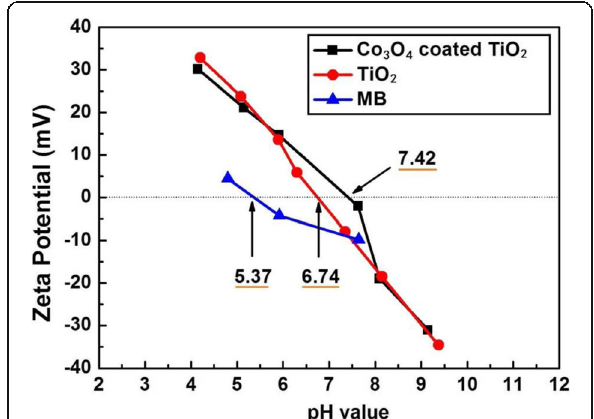
Fig. 8 Zeta potential of MB, P25, and Co 3 O 4 -coated P25 in aqueous solutions as a function of pH